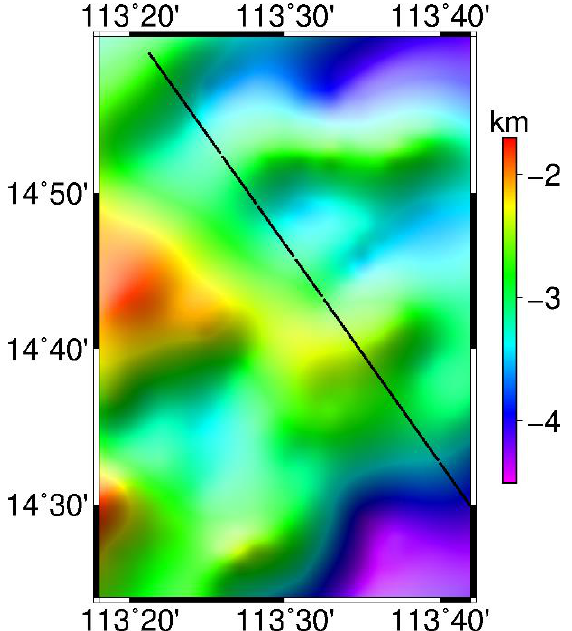
Figure 7. Shipborne gravity track and surrounding submarine topography for power spectral density (PSD) analysis.